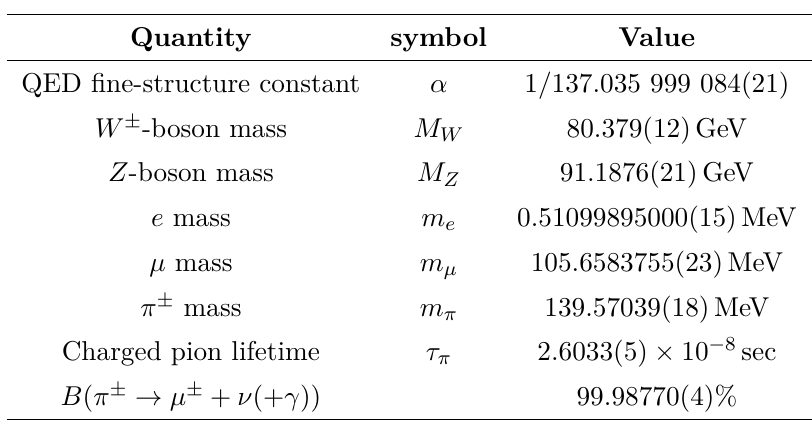
Table 1 . Input parameters used in the analysis taken from ref. [34]. We use the weak mixing angle defined in the on-shell scheme in eq. (2.9). Note that the values of the Fermi constant and the pion decay constant does not affect the final result as we take the ratio between the decay rates of the charged Wino and the charged